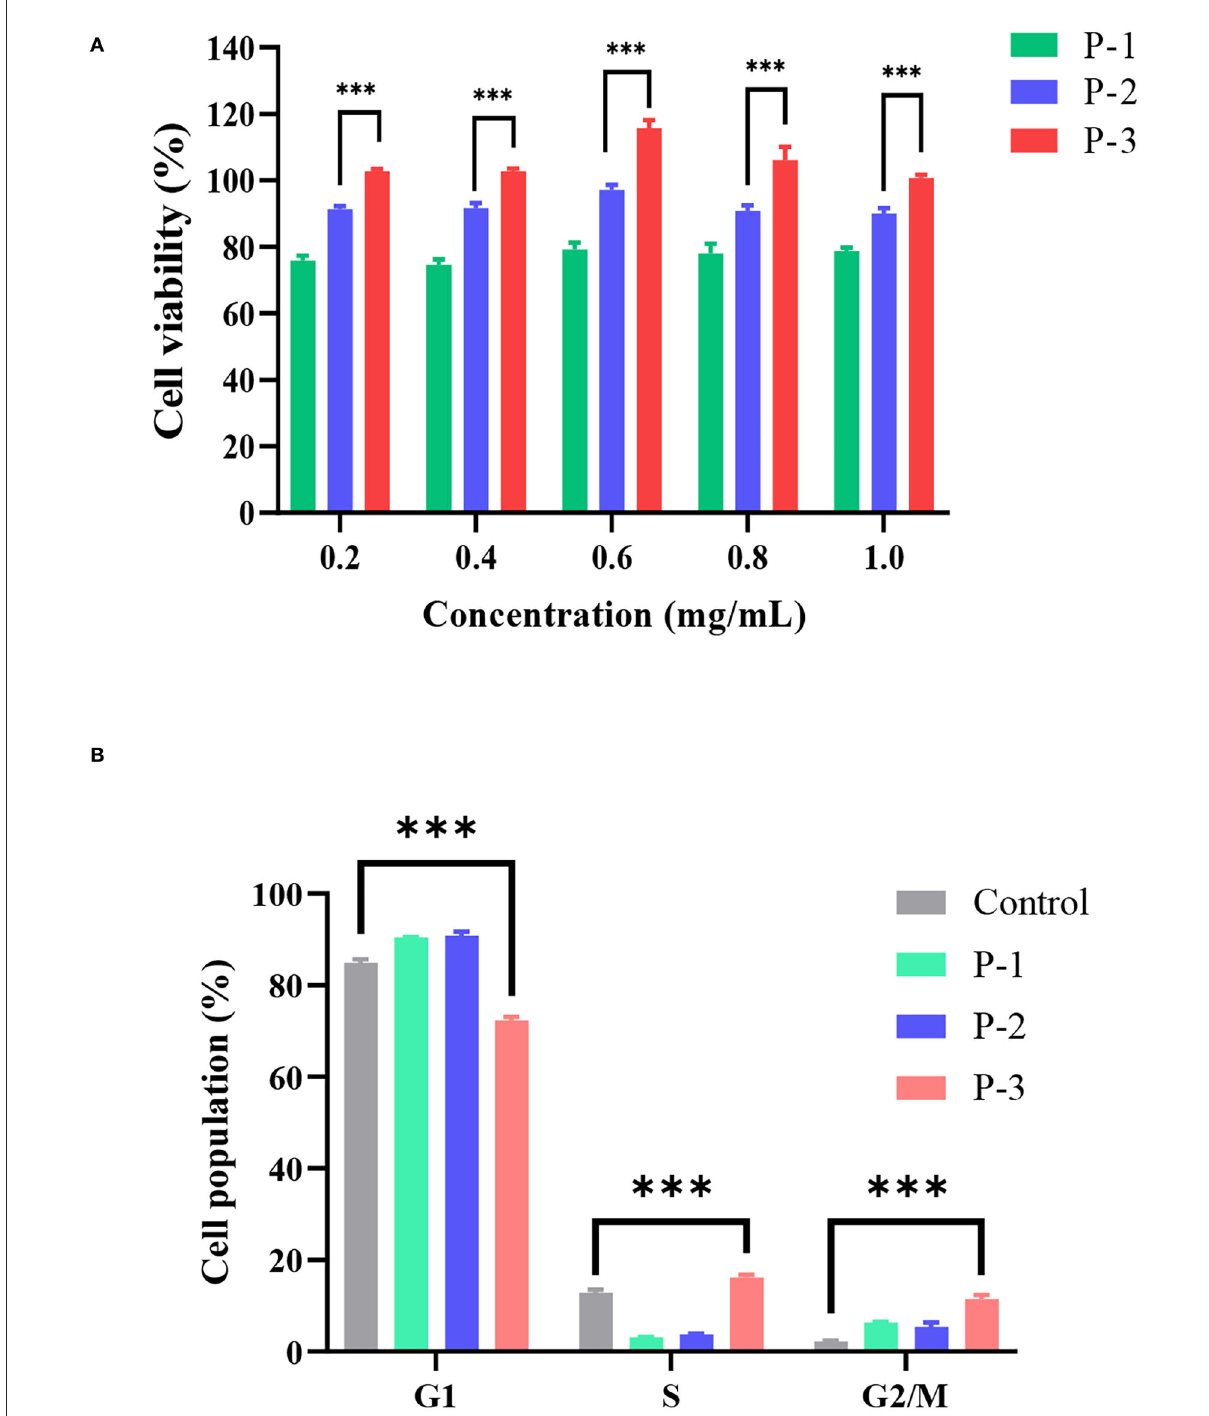
FIGURE2 (A) Cell viability determined by the MTT assay of HSF cells exposed to 0.2–1.0 mg/ml of P-1, P-2, and P-3 for 24h. The data were reported as percent viability compared to the control group. (B) Cell cycle of HSF cells determined by a flow cytometer exposed to 0.6 mg/ml of P-1, P-2, and P-3 for 24h. HSF cells only treated with DMEM medium for 24h were used as the control group. *** indicates differences at a p -value of <